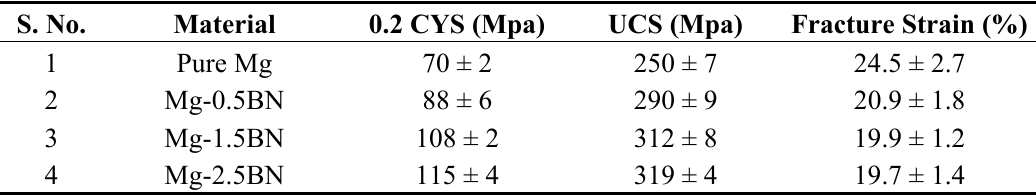
Table 6. Results of room temperature compression